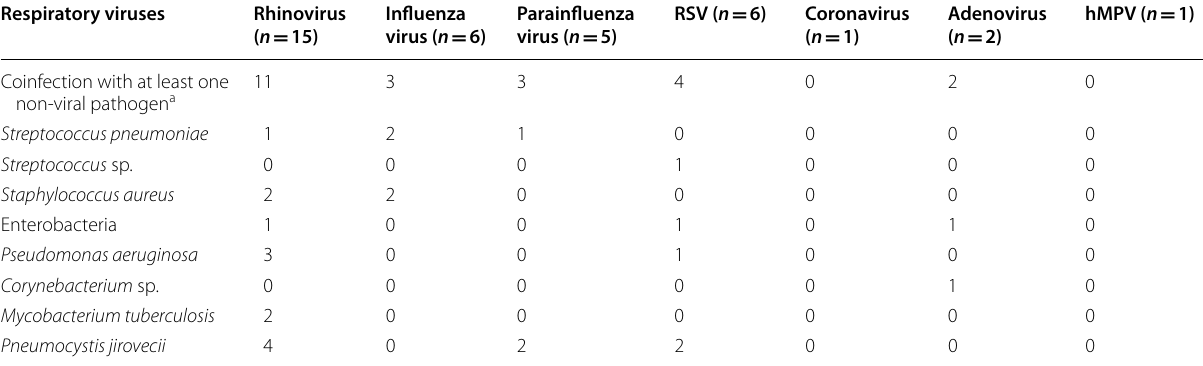
Table 3 Description of respiratory virus-associated infections and coinfections with non-viral pathogens